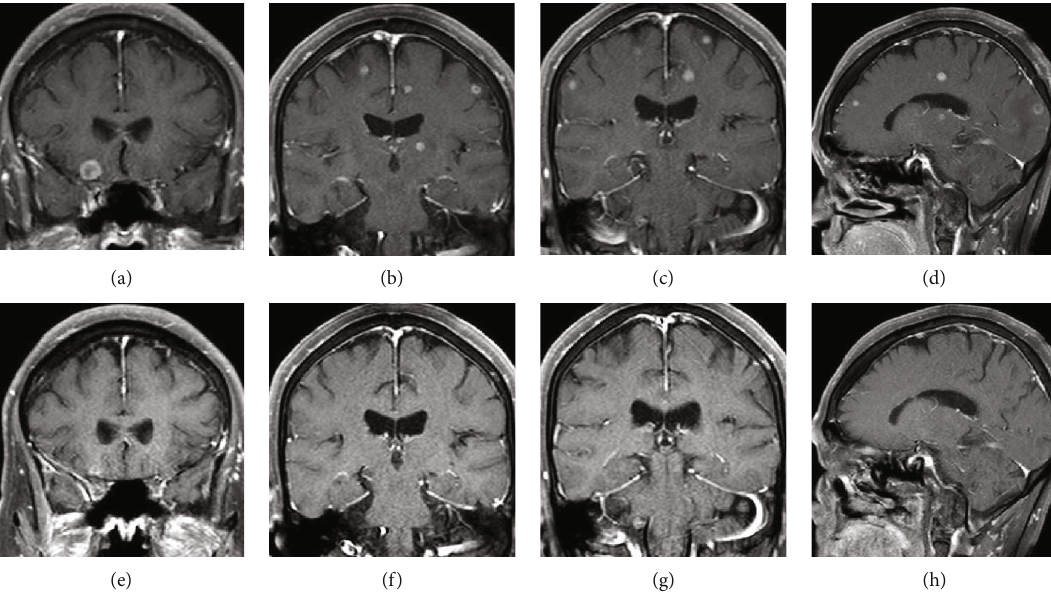
Figure 2: Multiple asymptomatic brain metastatic lesions (more than 20 in total) with a maximum diameter of 12mm were detected by gadolinium-enhanced MRI at the fi rst diagnosis (a – d). After 5 weeks, the multiple brain metastases had disappeared completely on contrast-enhanced brain MRI (e – h). Complete CNS response was con fi